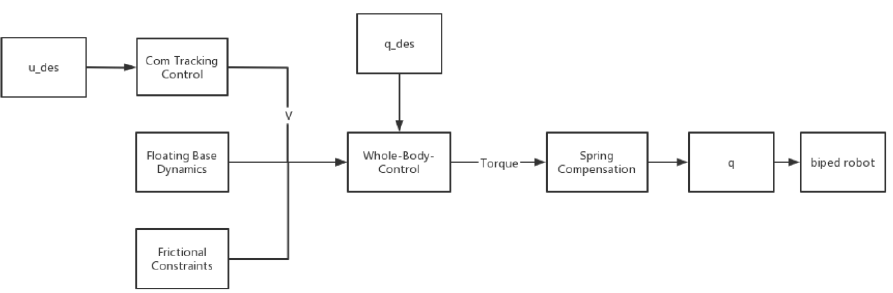
Figure 2. Control block diagram of spring compensation.